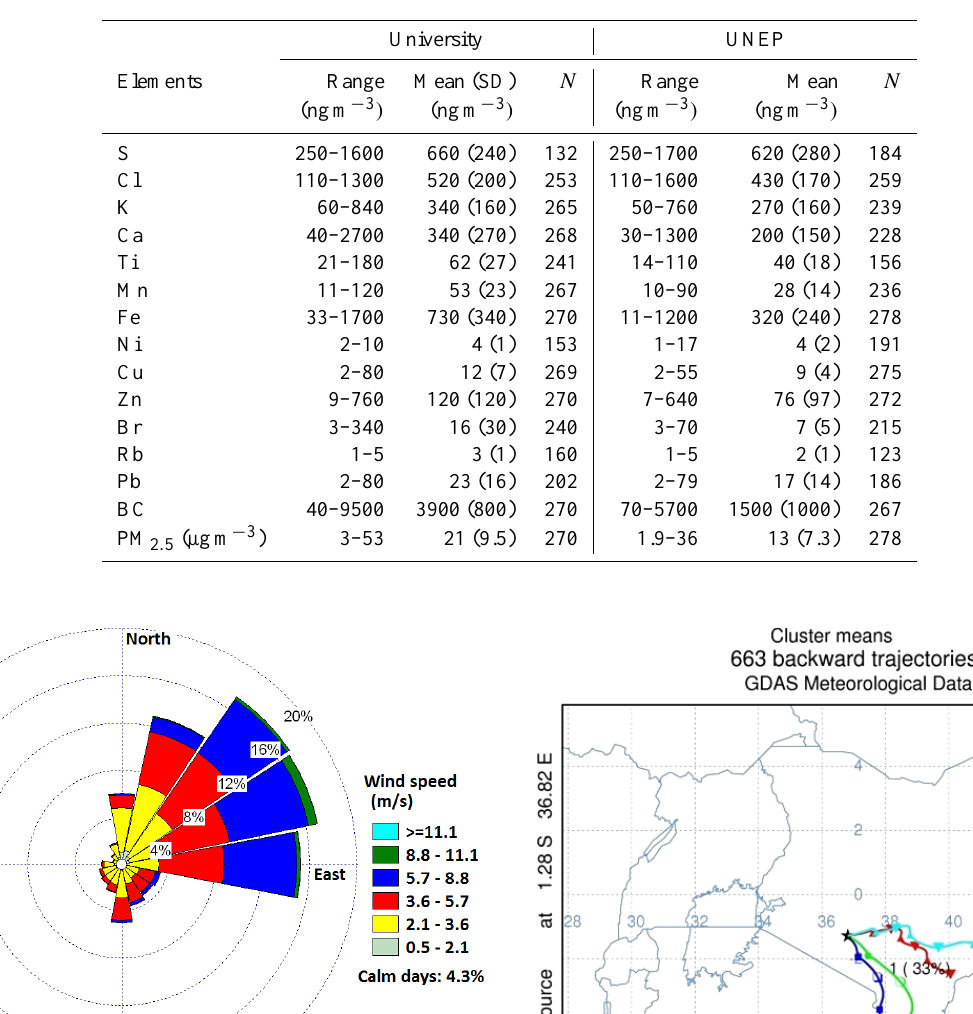
Table 2. Summary of the results from the university and the UNEP site for the time period from 16 April 2009 to 30 March 2010: range, mean concentrations and standard deviations (SD) for detected trace elements, BC (in ngm − 3 ) and PM 2 . 5 (in µgm − 3 ) . N is the number of valid samples.